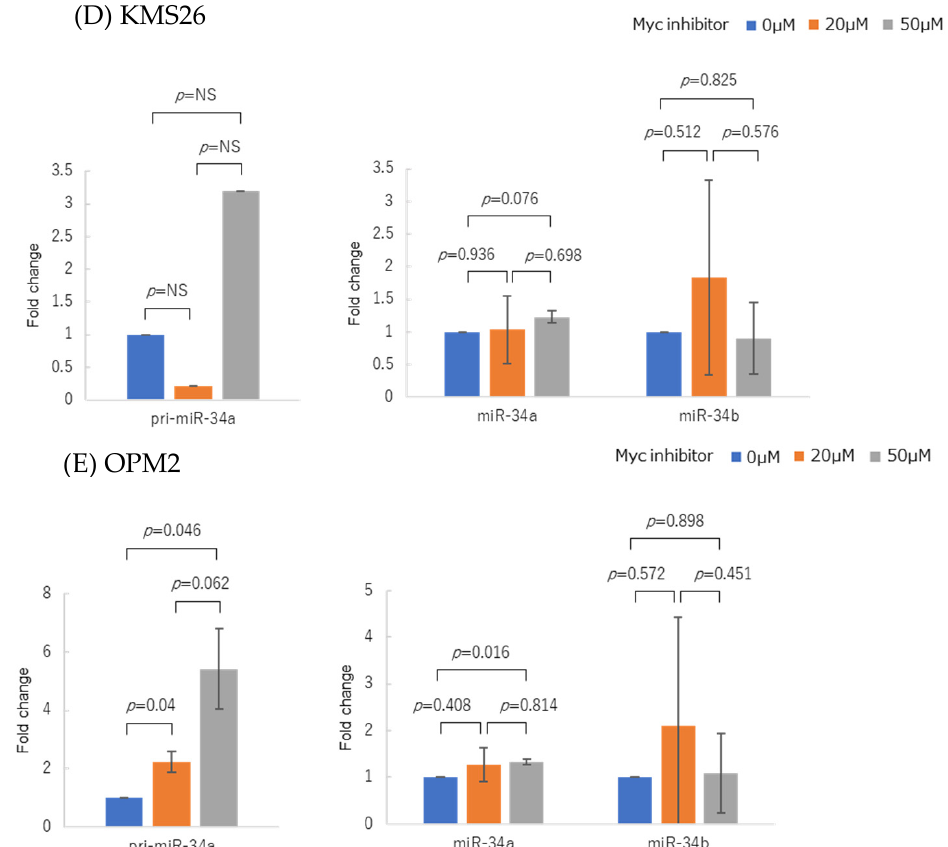
Figure 5. Changes in pri-miR-34a and mature miR-34a/b expressions in myeloma cell lines treated with Myc inhibitor 10058-F4. ( A ) MM.1S was treated for 48 h with Myc inhibitor at concentrations of 0 µM, 20 µM, and 50 µM. ( B ) KMS27, ( C ) KMS28BM, ( D ) KMS26, and ( E ) OPM2 were treated for 72 h with Myc inhibitor. Experiments were performed three times. Error bars show the standard deviation (SD) within triplicated experiments. Blue, with 0 µM Myc inhibitor; orange, with 20 µM Myc inhibitor; gray, with 50 µM Myc inhibitor. NS: Not significant.